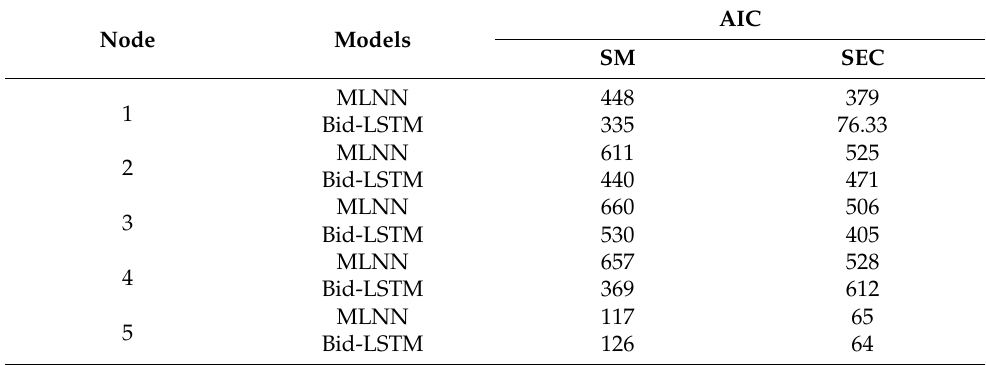
Table 2. The calculation results of AIC for Bid-LSTM and MLNN model for different datasets.